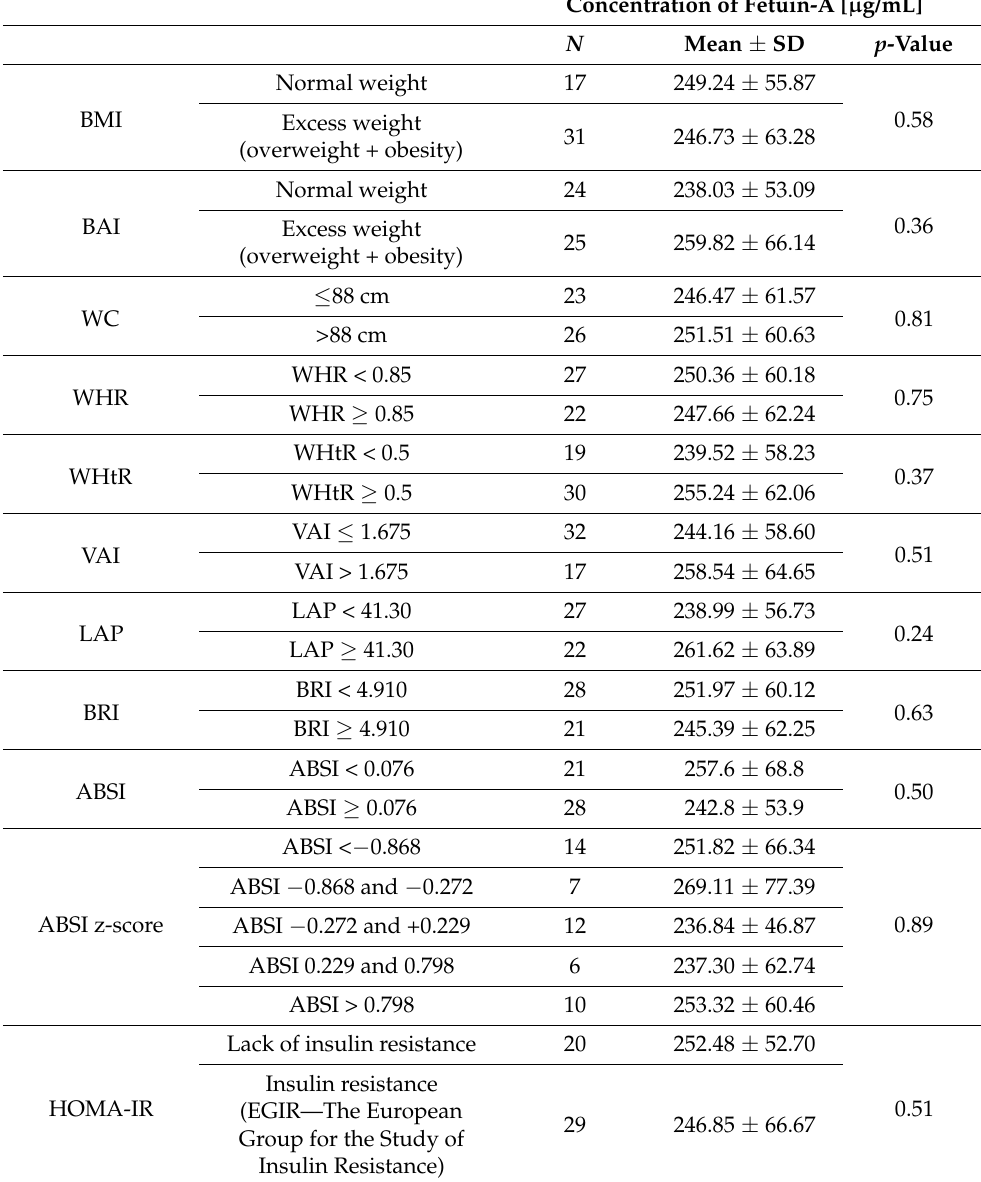
Table 6. Concentration of fetuin-A according to anthropometric parameters and indices and health